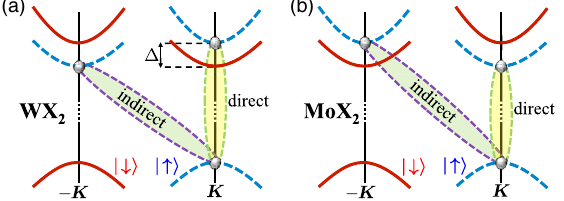
FIG. 3. The geometry studied in this work is that of a ML-TMD sandwiched between two other materials. The thickness of the ML, including the van der Waals gap, is d . The dielectric constants of the ML, bottom, and top layers are ϵ ϵ , t